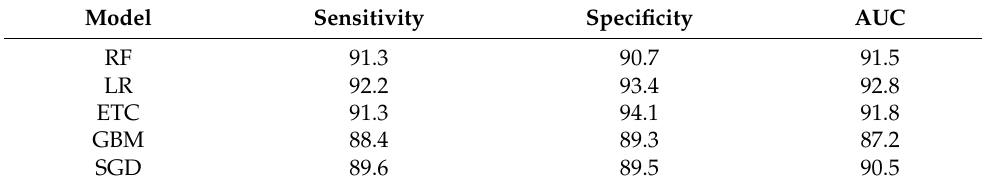
Table 5. Results of machine learning models for school